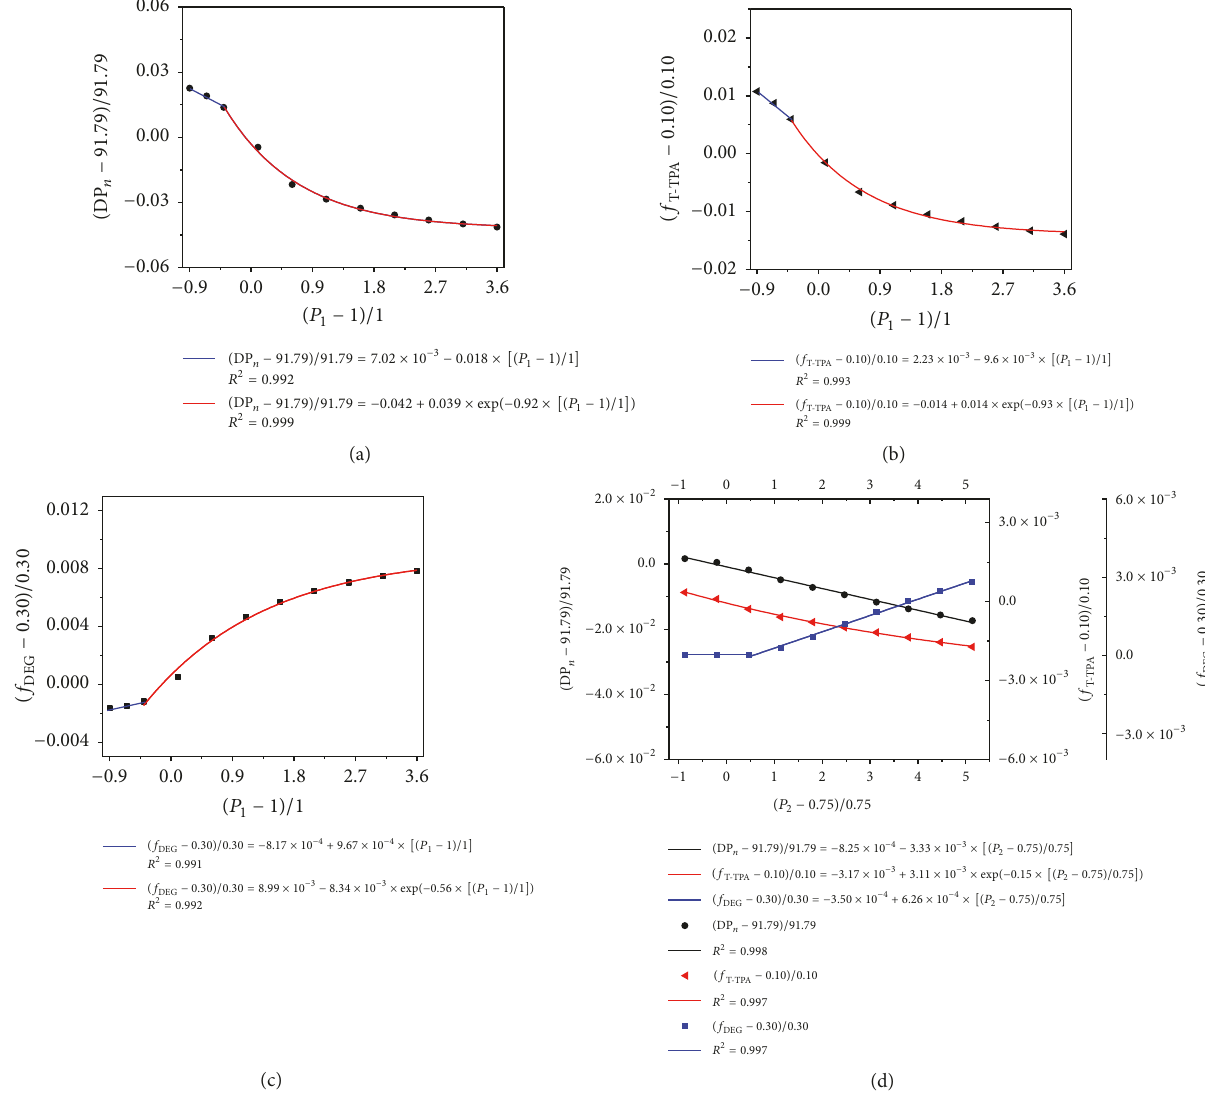
Figure 6: Effects of pressure in (a–c) falling film reactor and (d) rotating disk reactor on the quality indexes of liquid polymerization product.